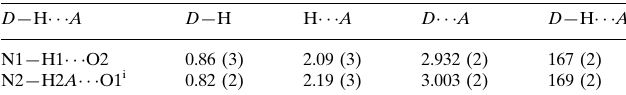
Hydrogen-bond geometry (A˚ , (cid:4)